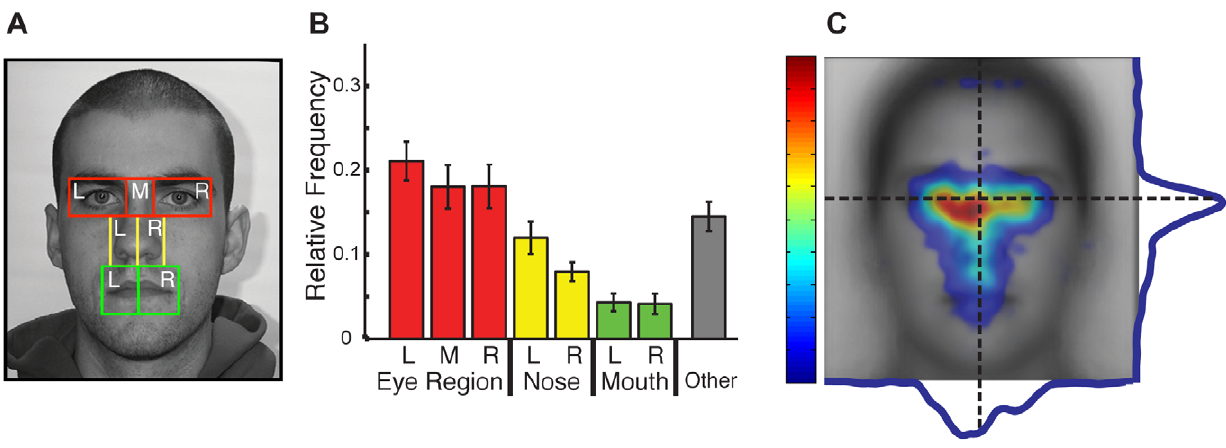
Figure 3. Distribution of fixations for upright faces averaged across start positions. ( a ) Example of AOIs for one face. AOIs could be divided into three separate feature regions: eye (red), nose (yellow), and mouth (green). ‘L’, ‘M’ (eye region only), and ‘R’ refer to the left, middle, and right, respectively, of the facial feature regions. ( b ) Relative frequencies of fixations across AOIs for the first five fixations revealed more fixations to the eye region compared with the nose and mouth regions. Error bars indicate the between-subjects standard error. ( c ) Spatial density and profile plots for the first five fixations showing more fixations to the eye region with a tendency toward the left side of the face. The face plotted beneath the spatial density plot is the average of all faces after alignment. Fixations are plotted as Gaussian densities summed across trials and participants. Fixation density is indicated using a colorscale from zero to the maximum density value observed, with zero being transparent. Profile plots to the right and below the spatial density map are summations of the spatial densities across each dimension. The vertical dotted line indicates the midline of the average face. The horizontal dotted line indicates the vertical position of the center of the eyes.